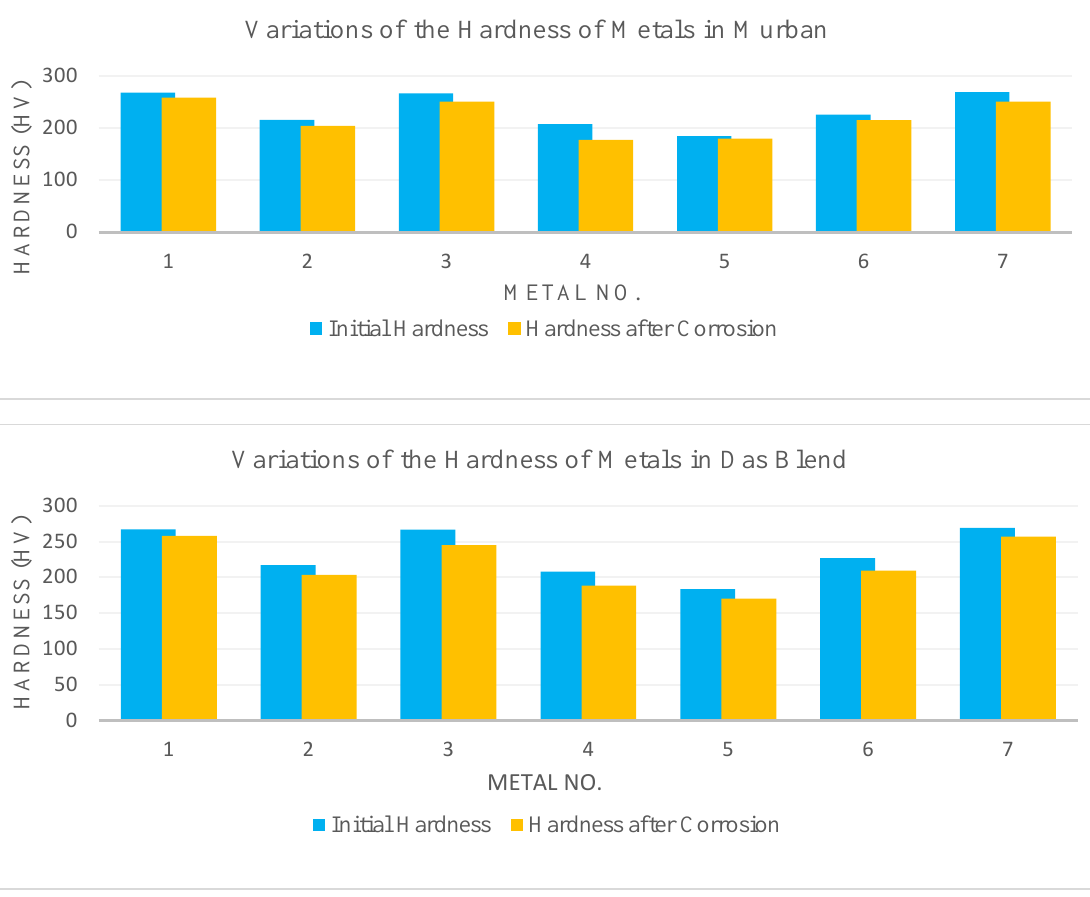
Figure 4. The average values of the variation of hardness in both crude